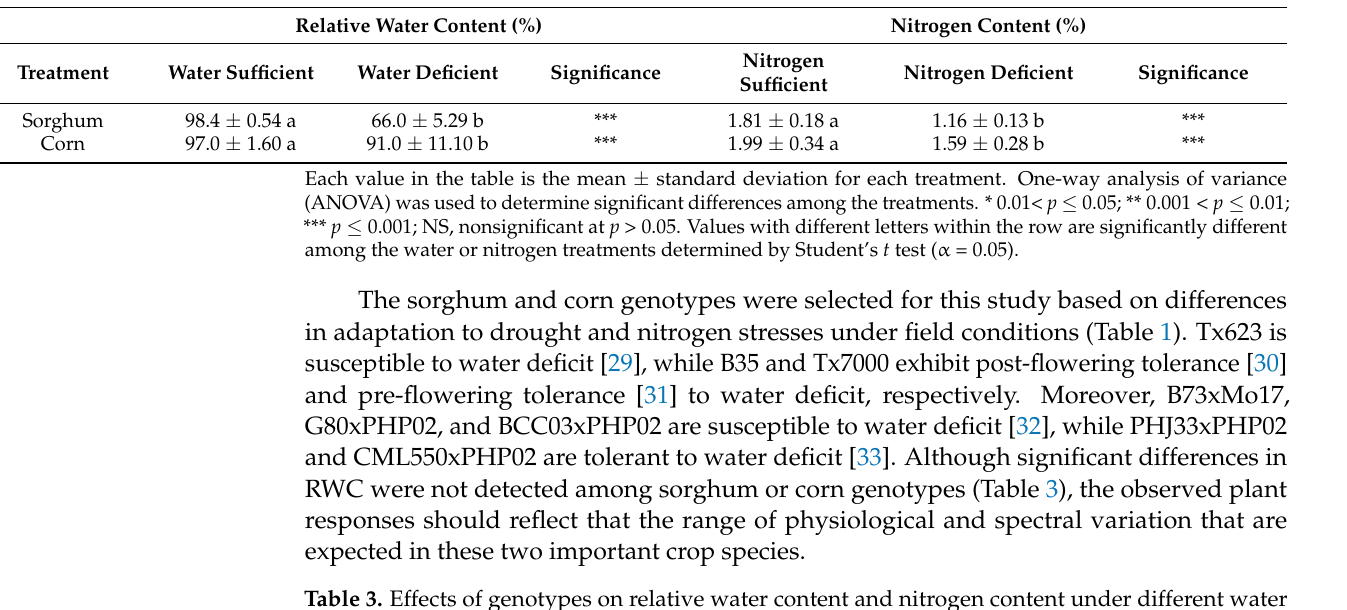
Table 2. Effects of treatments on relative water content and nitrogen content for sorghum and corn.